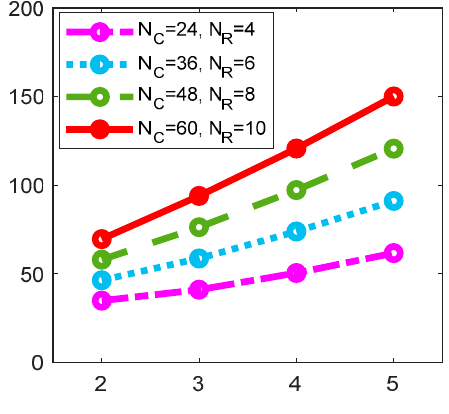
Figure 16. Ratio of DOFs.